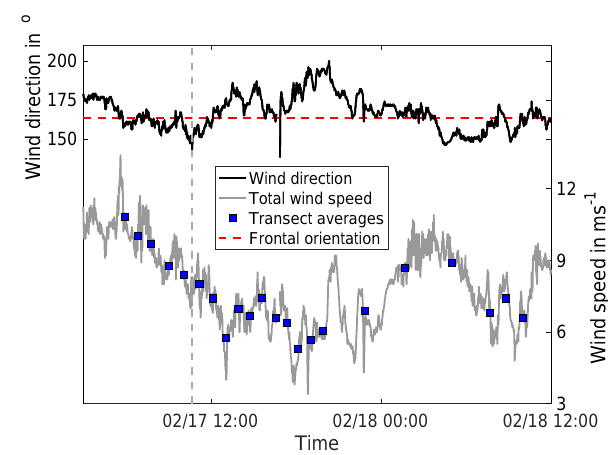
Figure 4. Time series of total wind speed (grey) and wind direction (black) from underway measurements at 35.3m height. Blue rect- angles show mean total wind speed for each zonal and cross-frontal transect. The dashed red line shows the (initial) frontal orientation deduced from the frontal mapping. The angle of 163.44 ◦ impli- cates the front running from south–southeast to north–northwest. The vertical dashed grey line indicates the transition from zonal to cross-frontal transects. Time is given in